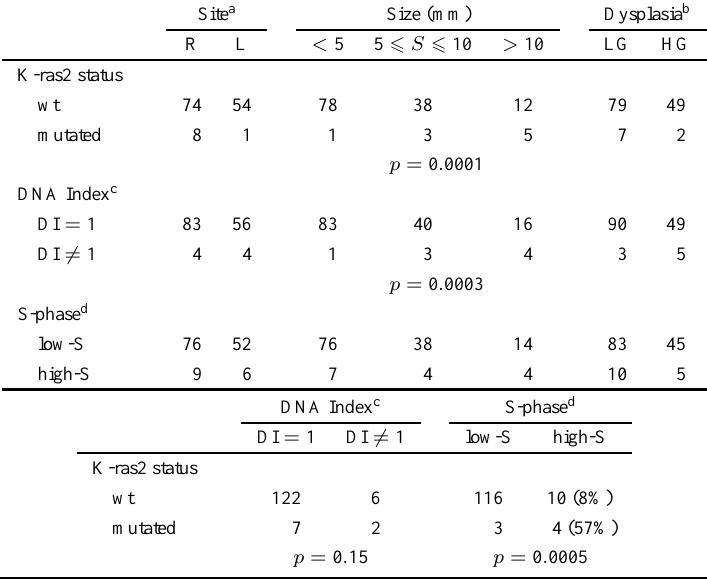
K-ras2 status, DNA ploidy, S-phase versus site, size, dysplasia, and K-ras2 status versus DNA ploidy and S-phase in 147 adenomas from 4 FAP patients Site a Size (mm) Dysplasia b